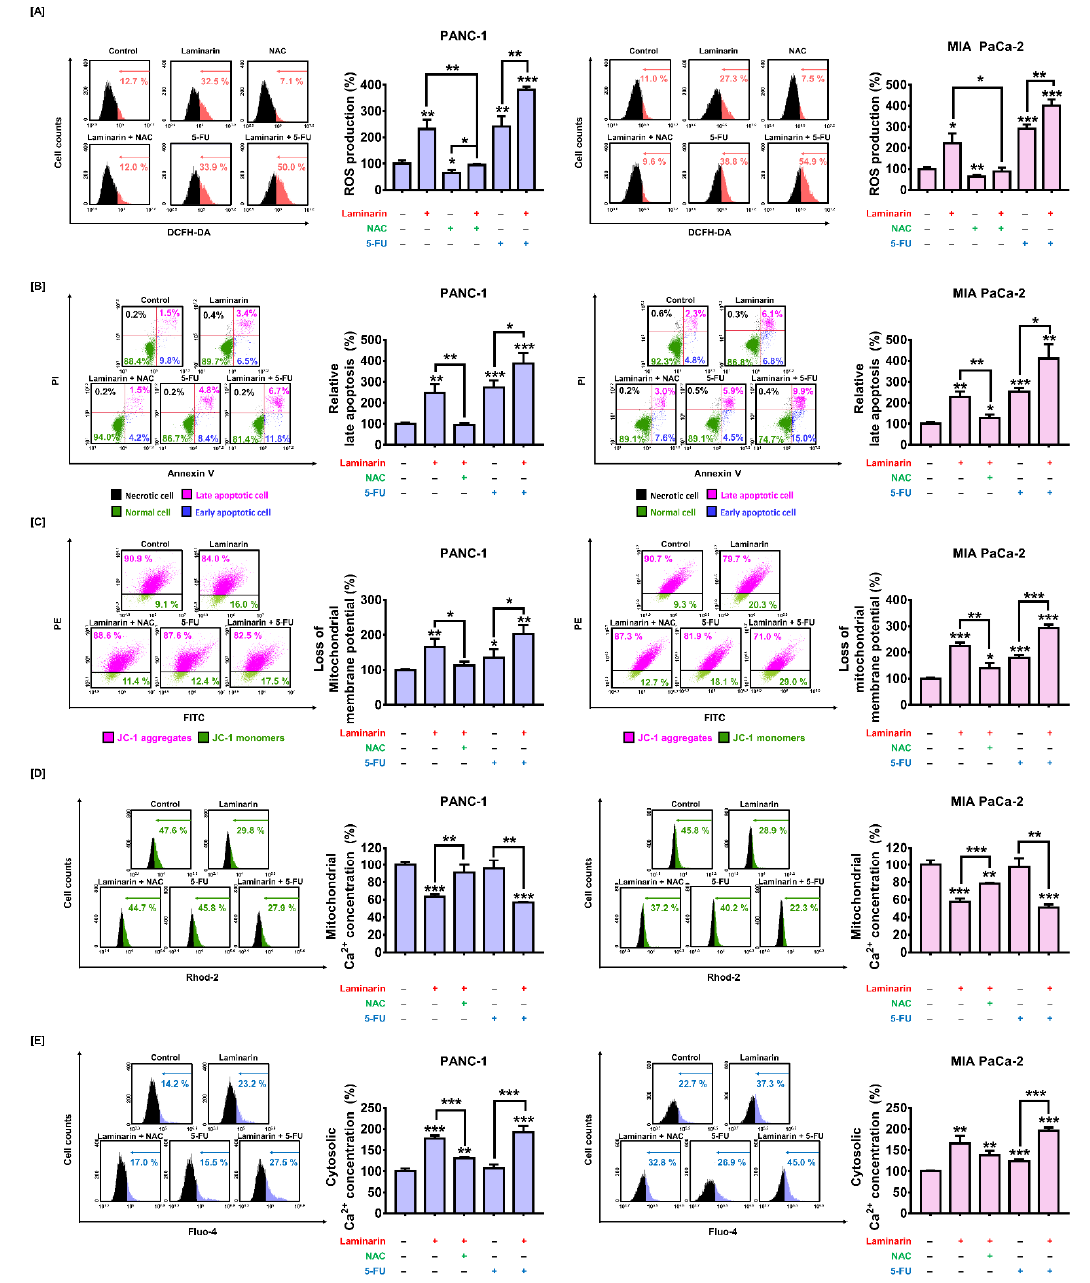
Figure 6. Synergistic effects of laminarin (2 mg/mL) and 5 ‐ FU (20 μ M) in PC cells. Effects on ( A ) ROS production, ( B ) apoptosis, ( C ) MMP, ( D ) mitochondrial, and ( E ) cytosolic calcium concentrations. (* p < 0.05, ** p < 0.01, and *** p < 0.001). All experiments were conducted in triplicate. 5 ‐ FU, 5 ‐ fluorouracil; MMP, mitochondrial membrane potential; PC, pancreatic cancer; ROS, reactive oxygen species.